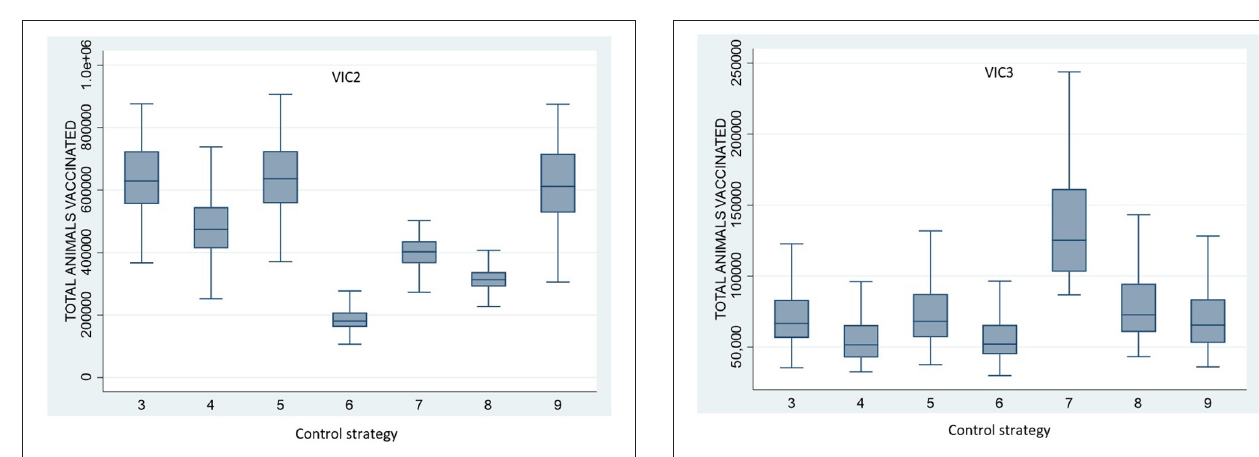
FIGURE 4 | Boxplots of the total number of vaccinated animals for Scenario VIC2 for the control strategies with vaccination (Control Strategy 3 to 9).